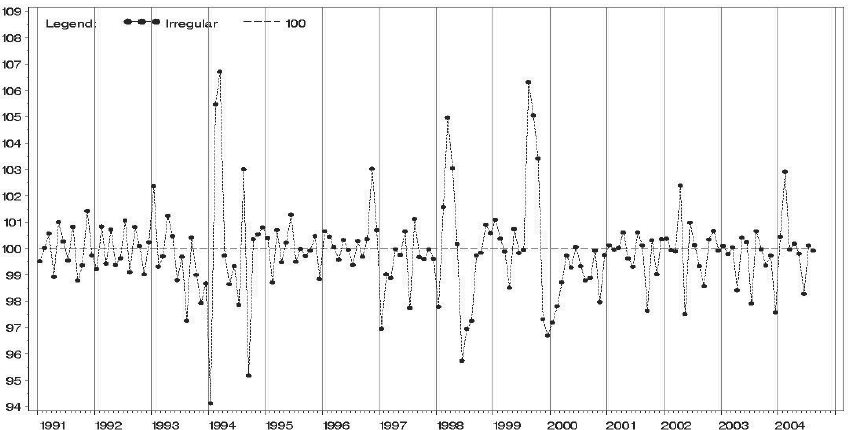
Fig. 3 – Irregular component of Sales by Canadian Department